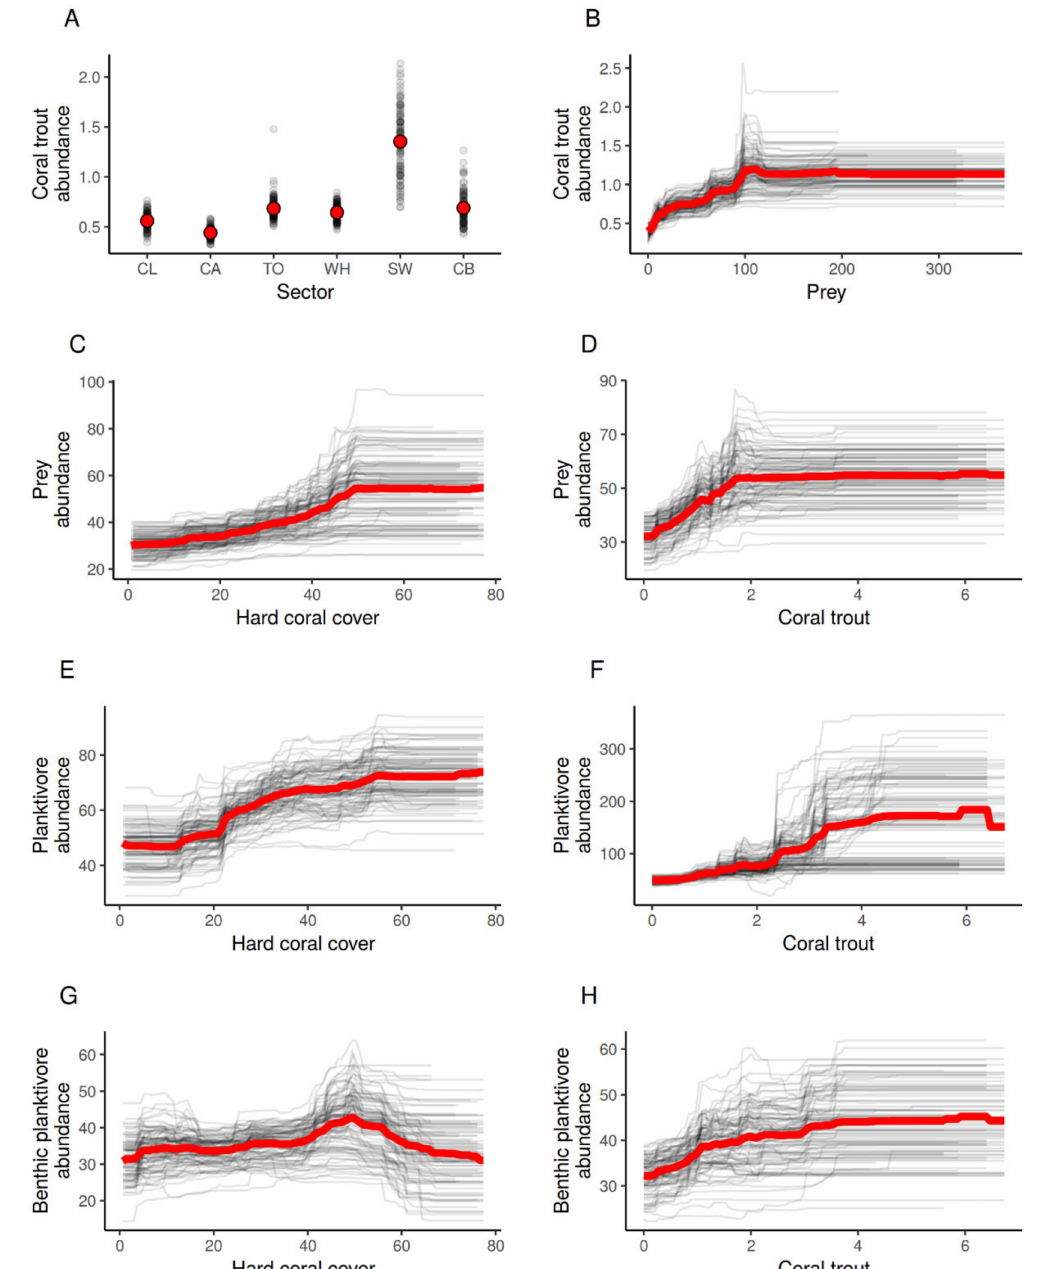
Figure 6. The relationship between the most influential predictor variables and ( A , B ) coral trout, ( C , D ) coral trout prey, ( E , F ) planktivore abundance and, ( G , H ) benthic planktivore abundance. Grey lines are individual runs of the model ( n = 100) while the red line shows the mean